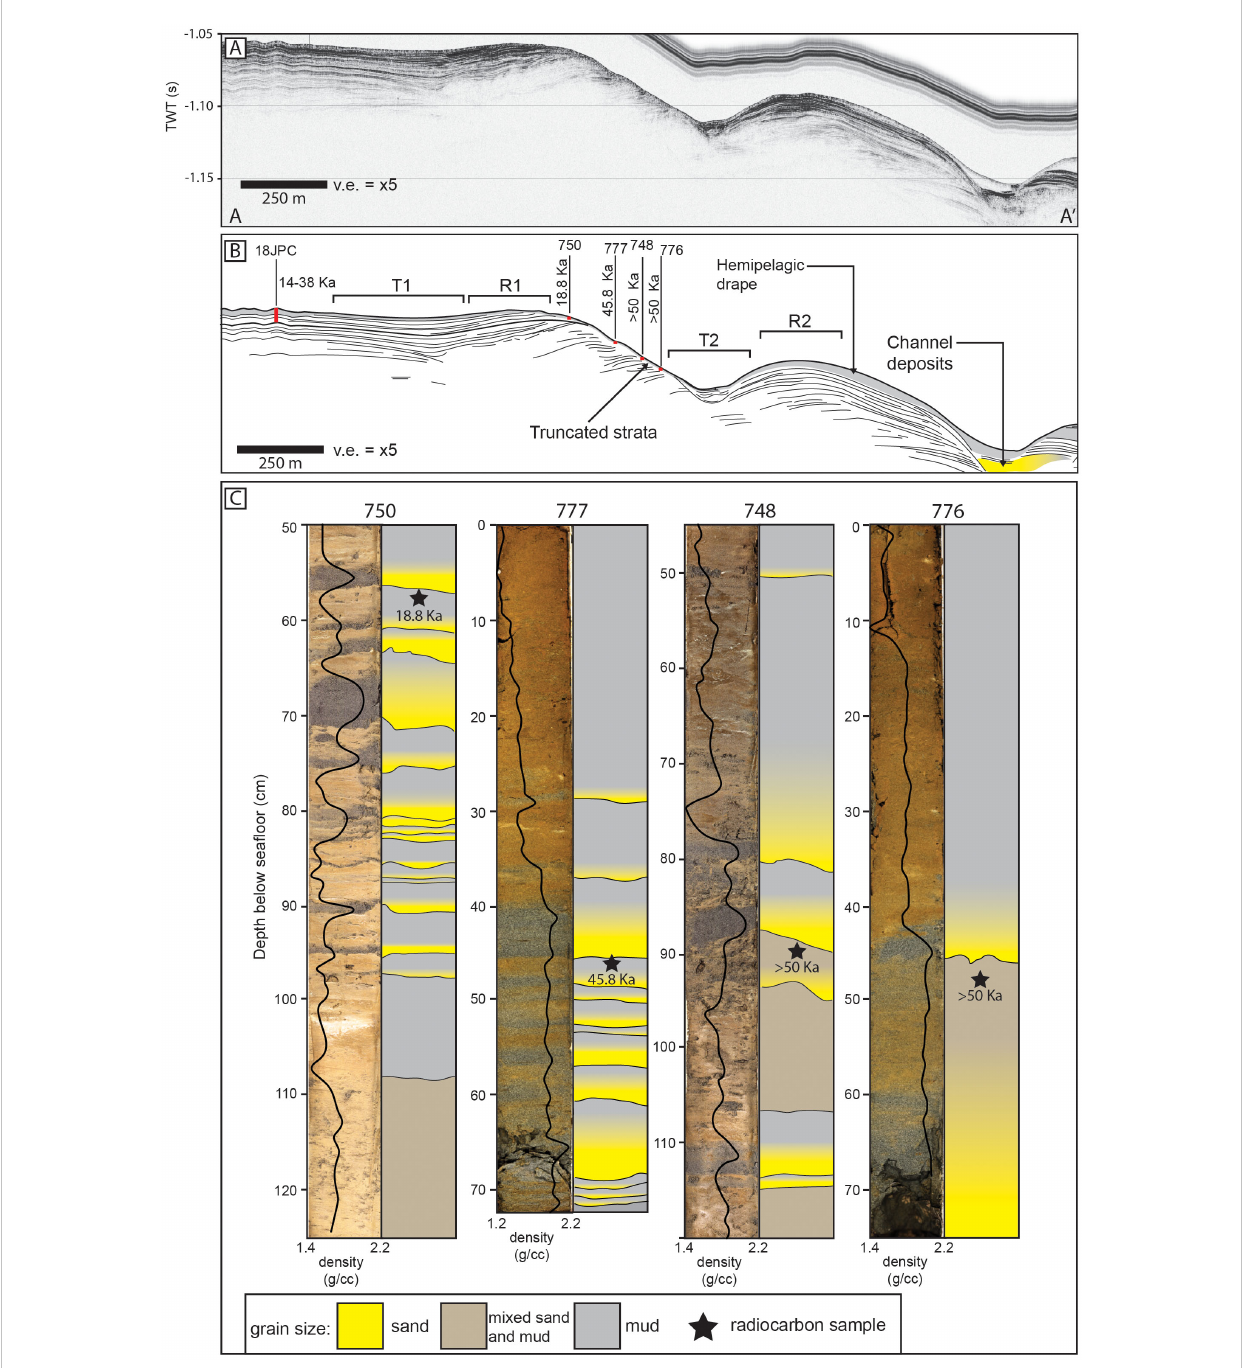
piston core 18JPC. Locations of cores and approximate penetration depths are noted by the red rectangles. Note the zone of truncation at the R1- T2 slope that exposes Pleistocene-aged turbidites. (C) Images, density logs, and grain size interpretation of vibracores exposed along a R1-T2 surface shown in (A, B) Note the high amount of sand beds in all cores. T1, Trough 1; R1, Ridge 1; T2, Trough 2; R2, Ridge